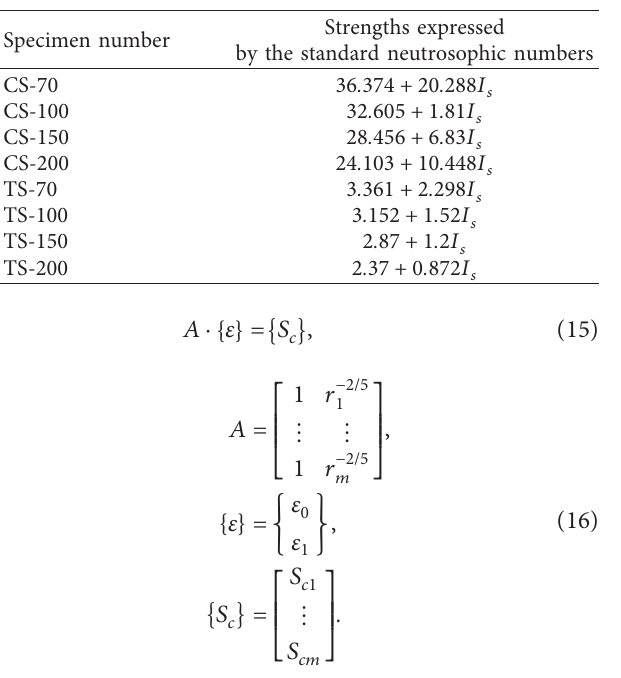
Table 7: Strength values expressed by the standard neutrosophic numbers (“CS” denotes the compressive strength; “TS” denotes the tensile